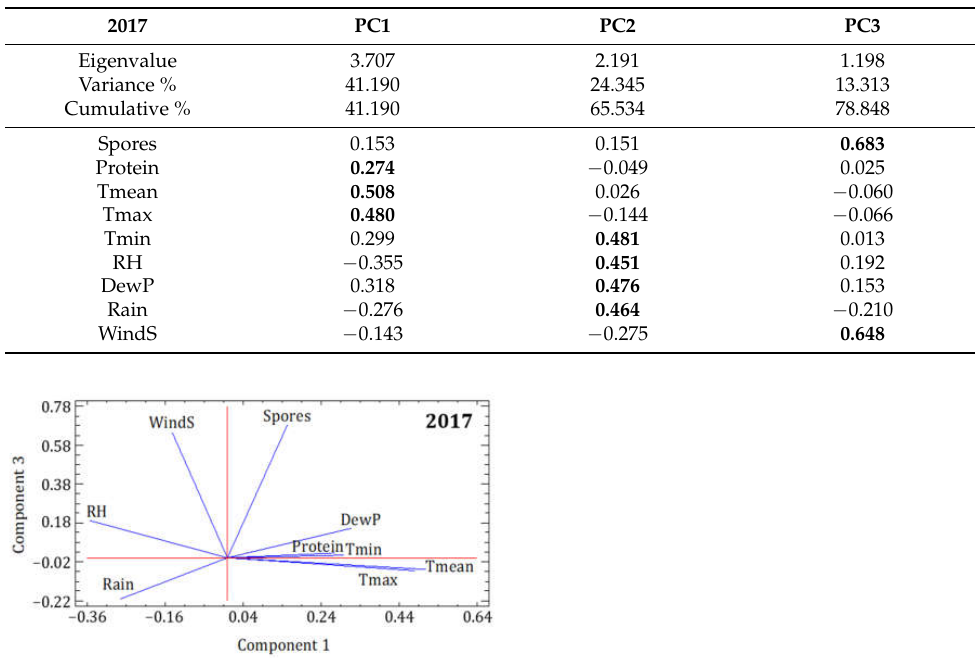
Figure 5. Graph of component weights of the considered variables for the 2017 Principal Component Analysis, representing CP3 vs. CP1. Table 2. Principal Component Analysis coefficients for 2018 and factor loadings of the considered variables. In bold, the largest correlation coefficient for each variable.